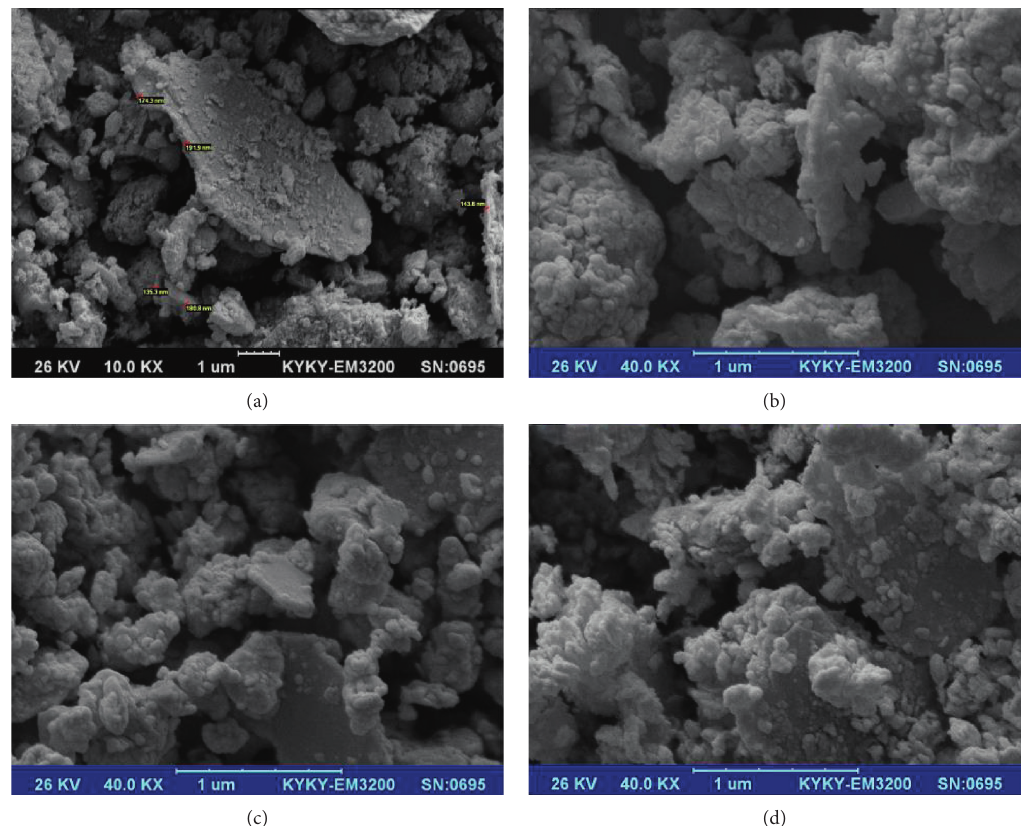
Figure 5: SEM images of MMT K10 (a), MMT-[(CH